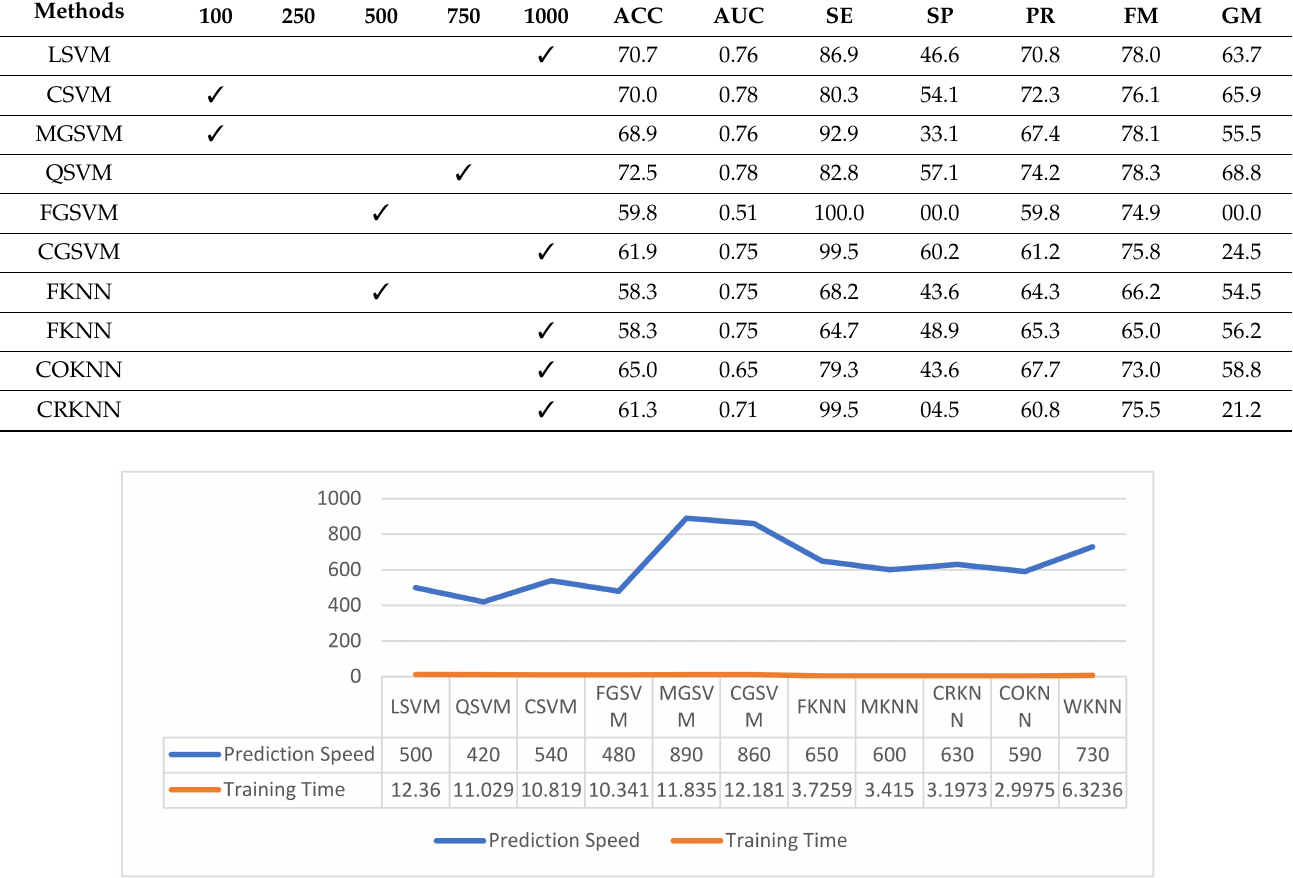
Figure 11. Proposed model training time (s) and prediction speed (obs/s) on back views of VIPeR dataset utilizing 1000-feature subset.